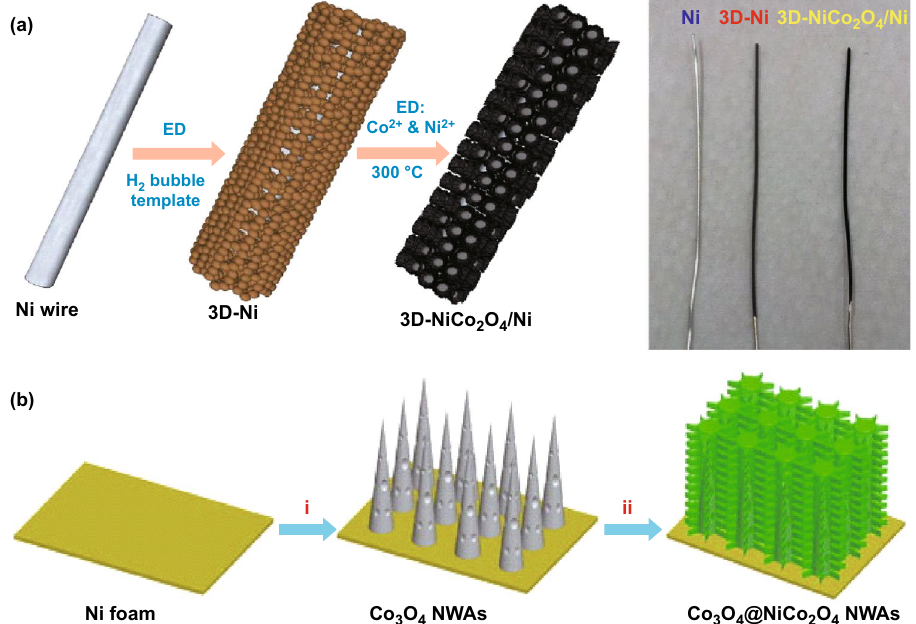
Fig. 17 a Electrodeposited 3D flower-like NiCo 2 O 4 /Ni nanostructures on Ni-wire. Reproduced with permission from Ref. [169], Copyright © 2016 The Royal Society of Chemistry. b Schematic representation of the formation of nanoforest hierarchical composites Co 3 O 4 @NiCo 2 O 4 nanowire arrays. Reproduced with permission from Ref. [172]. Copyright © 2013 Elsevier